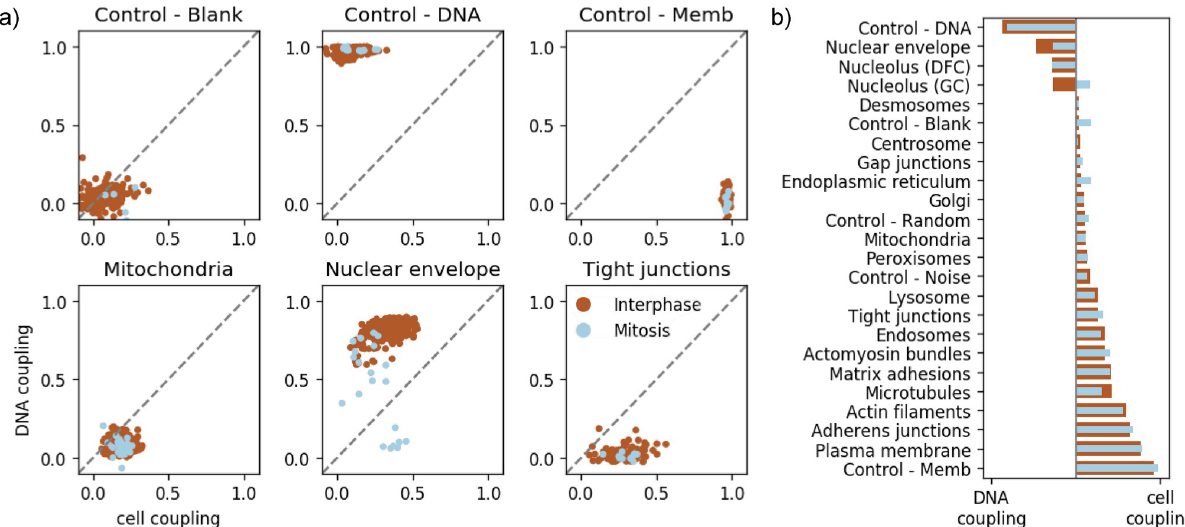
Fig 5. Quantification of the coupling of cellular morphology and subcellular structure. a) shows the relative coupling strength of three structures to the nuclear shape (y-axis) and cell membrane (x-axis) of the cells in which they reside, according to Eq 4. Each point represents a cell; brown points are cells in interphase, blue points are cells undergoing mitosis. b) shows the relative degree of coupling of each structure to the cell membrane or nuclear channel, and how this changes during mitosis.